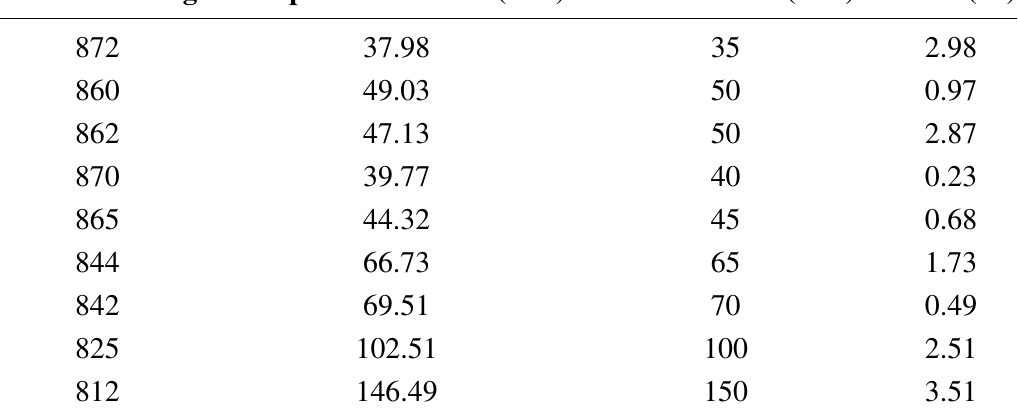
Table 4. Experimental results of computed diameter of spherical objects computed while the glove touches them. Results are based on 10-bit reading of ADC module and computed by a spline